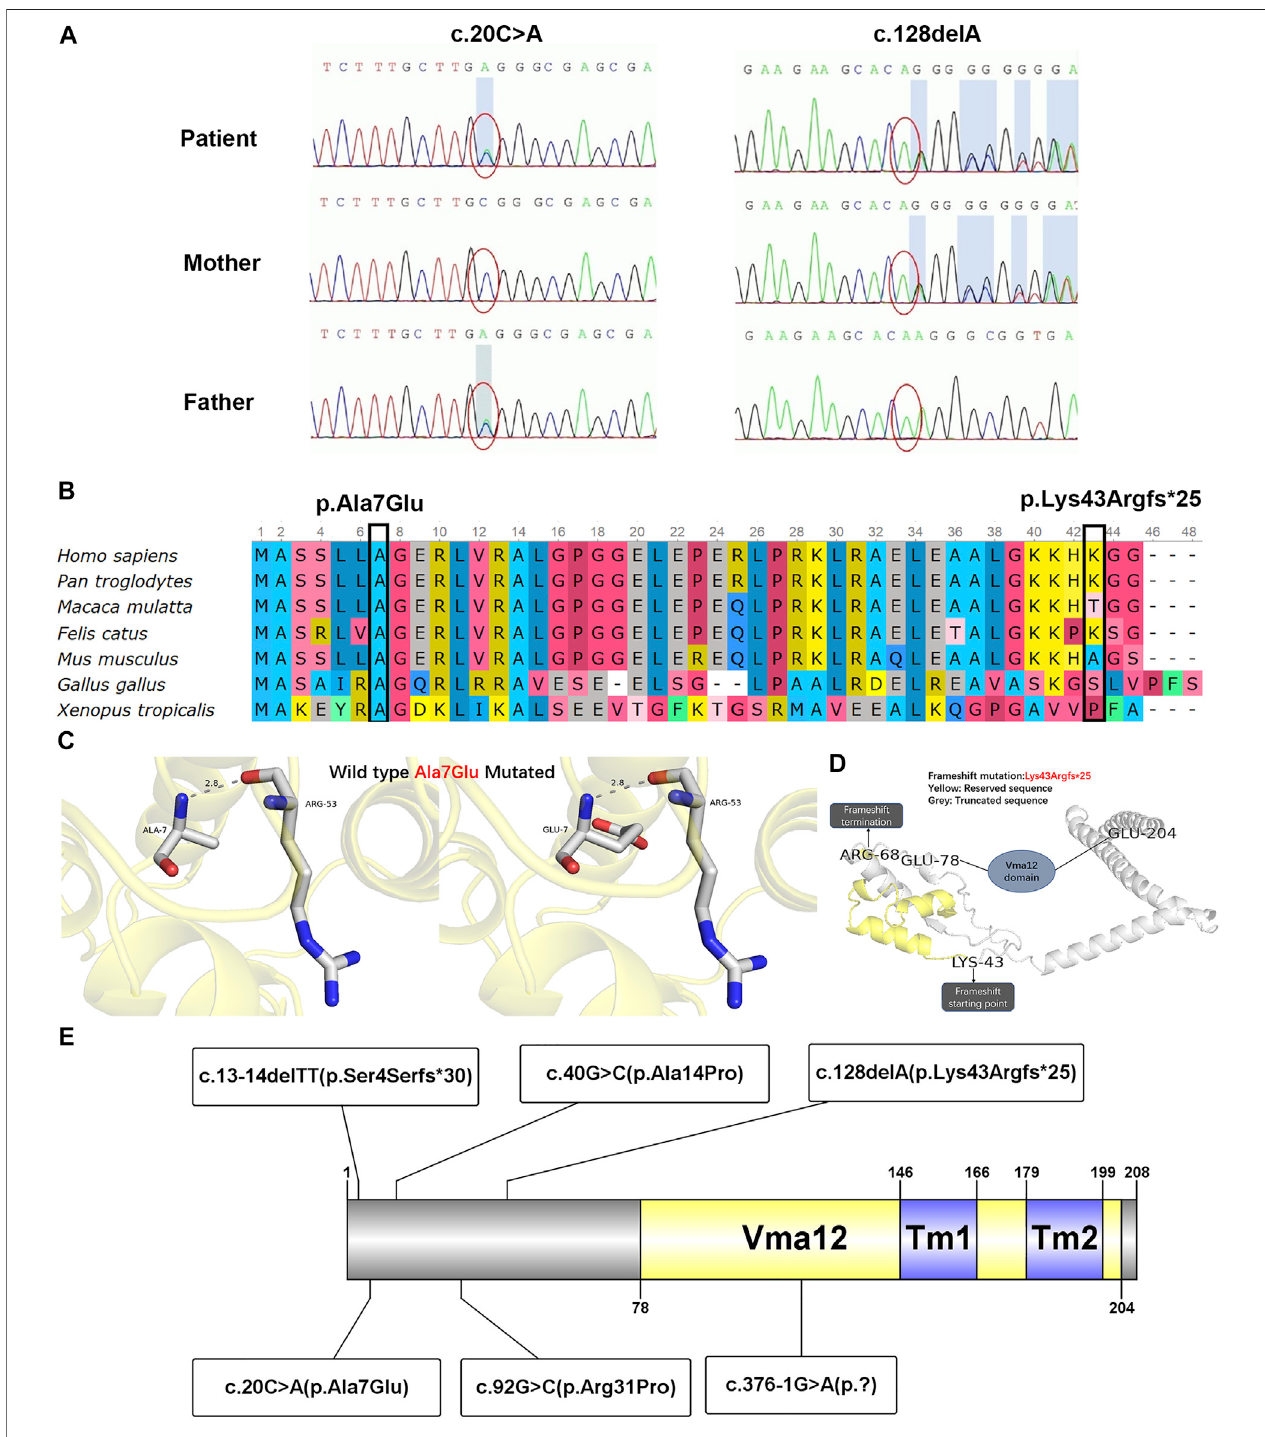
FIGURE 2 | Genetic testing results, conservation of amino acid residues, protein modulation, and distribution of reported variants with the TMEM199 protein. (A) Sangersequencing con fi rmationofc.20C > Aandc.128delAmutationof TMEM199 intheindex caseandhisparents. (B) Conservationstatus ofaminoacidresiduesof the two variants across various species. (C) Wild and mutated types of the p.Ala7Glu variant compared by PyMol. (D) Spatial conformation of the frameshift mutation (p.Lys43Argfs*25) showed by protein modeling. (E) Illustration of TMEM199 protein domains, location of amino acid changes of the reported variants so far.